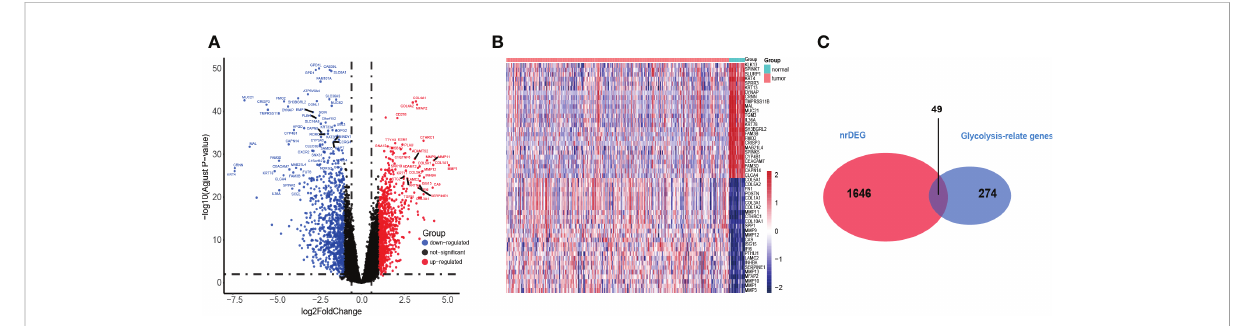
FIGURE 2 Identi fi cation of the HNSC-related DEGS in TCGA. (A, B) The volcano and heatmap plot showed differentially expressed genes between tumor and adjacent normal tissue. (C) Venn diagram showed glycolysis-relate differentially expressed genes between tumor and adjacent normal